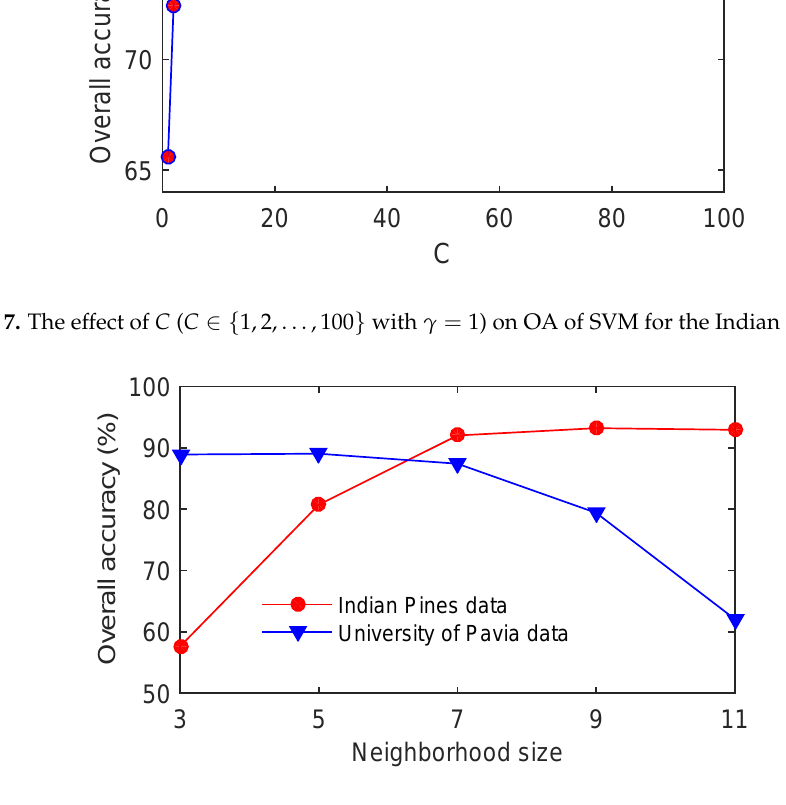
Figure 8. The effect of neighborhood size on OA of tbSRC for the two HSI data